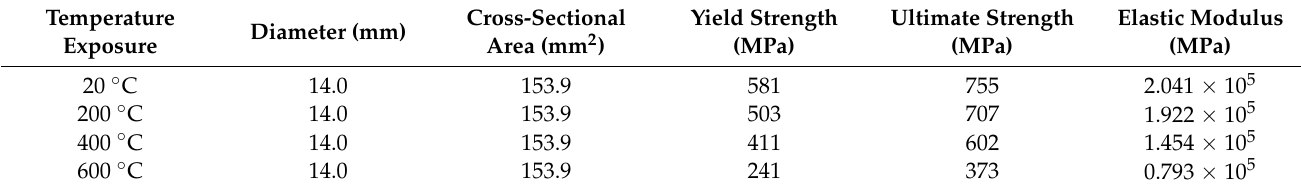
Table 2. Physical mechanical performance index of the steel fibers. Table 3. Mechanical performance of HRB500 rebar at different